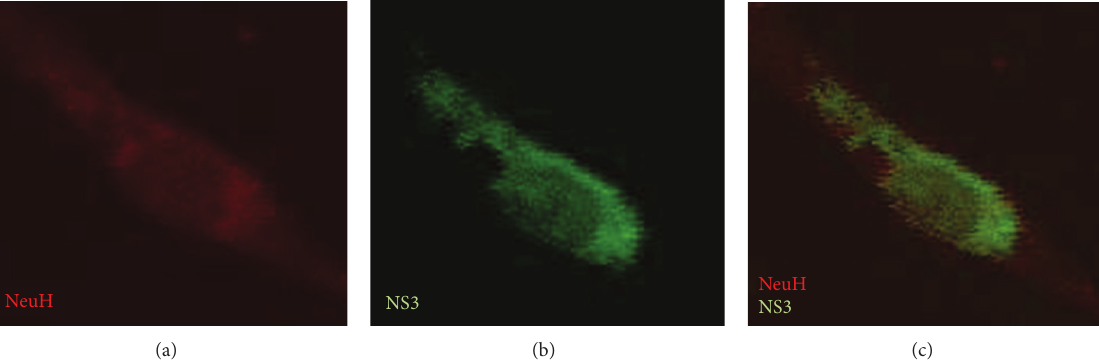
Figure 5: DENV-2 NS3 protein expresses in neurons. Detection of the viral replication by indirect immunofluorescence in primary cultures of human neural cells treated with DENV type 2 using an anti-NS3 monoclonal antibody by confocal microscopy. (b) and (c) Original magnification was 600x, but the pictures were cropped to improve